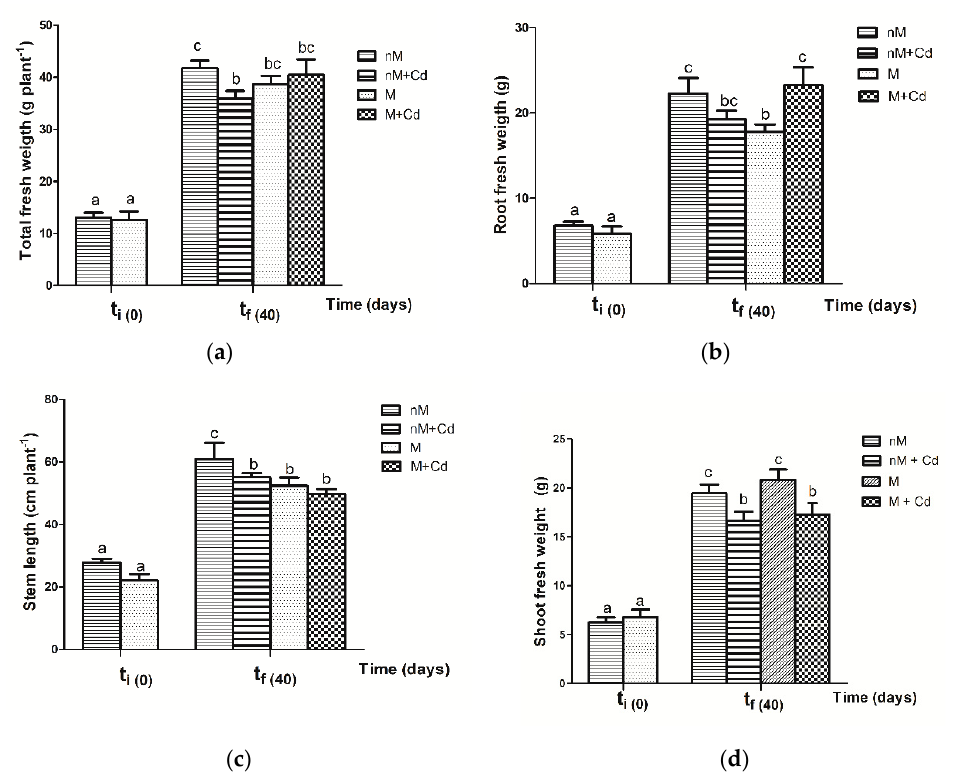
Figure 1. Effect of Cd stress on ( a ) total fresh weight; ( b ) root fresh weight; ( c ) stem length; ( d ) shoot fresh weight of non ‐ mycorrhizal (nM) and mycorrhizal plants (M) inoculated with Rhizophagus intraradices at initial time (t0) and after 40 days (tf) of Cd addition. Data are the means of six replicates ± SE for each dependent variable. Different letters indicate significant differences at p ≤ 0.05 using a two way ANOVA according to the least significant difference (LSD) post hoc test between treatments.